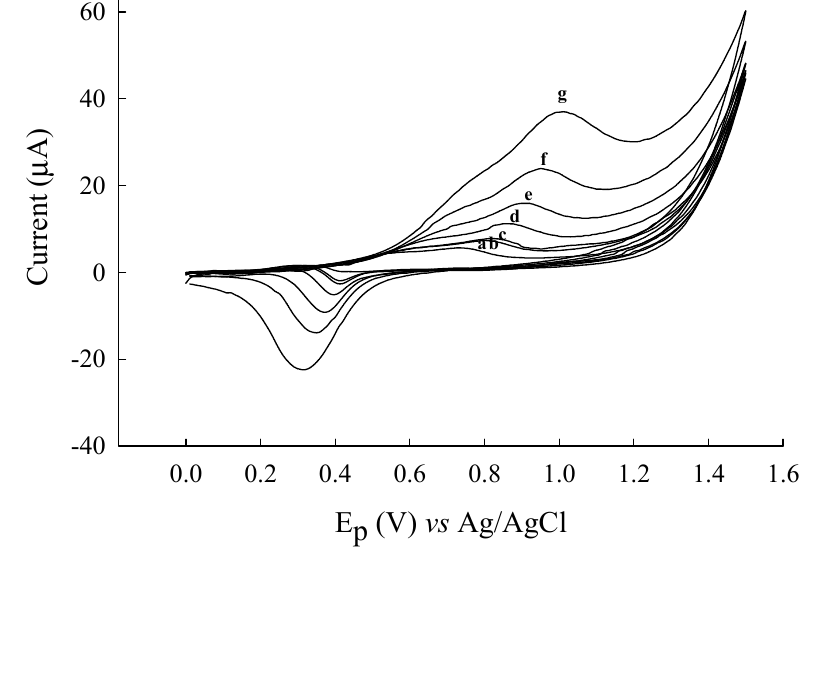
Figure 6. Cyclic voltammograms of cysteine 30.0 mg·L − 1 in Britton-Robinson buffer (pH 5.33) at various potential scan rates: ( a ) 5 mV/s; ( b ) 10 mV/s; ( c ) 12.5 mV/s; ( d ) 25 mV/s; ( e ) 50 mV/s; ( f ) 100 mV/s ( g ) 200